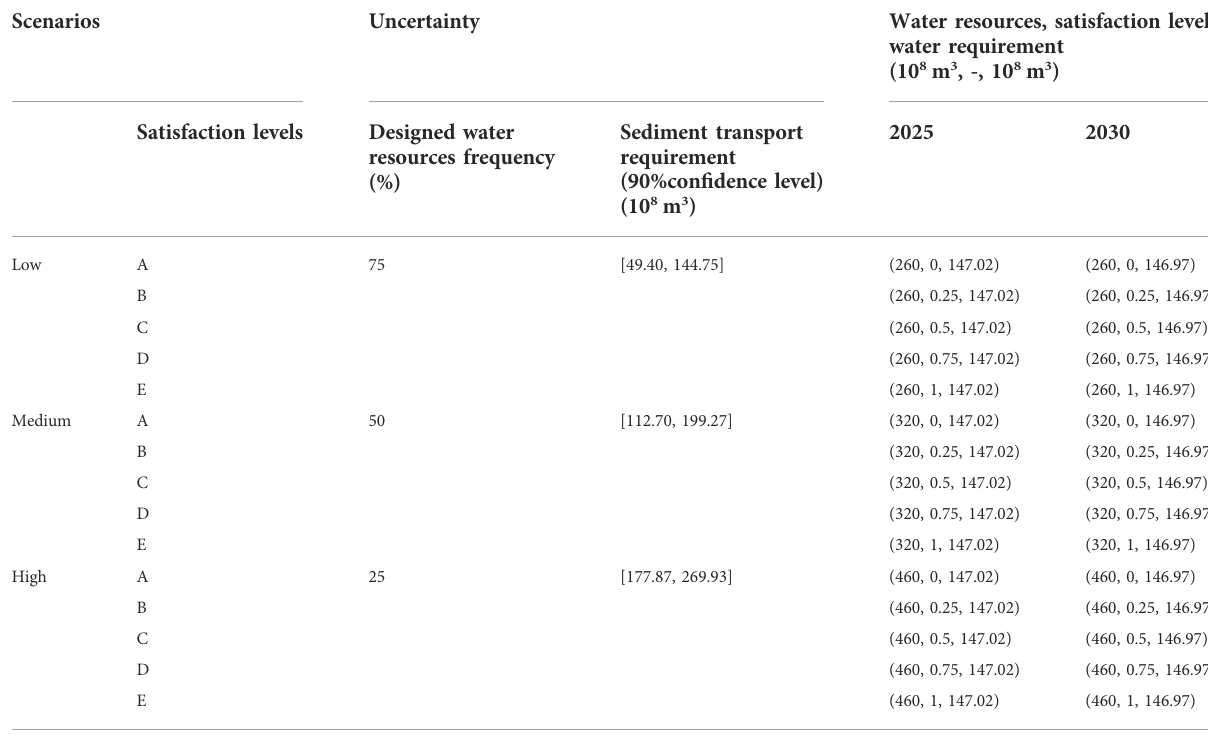
TABLE 6 Proposed plans.